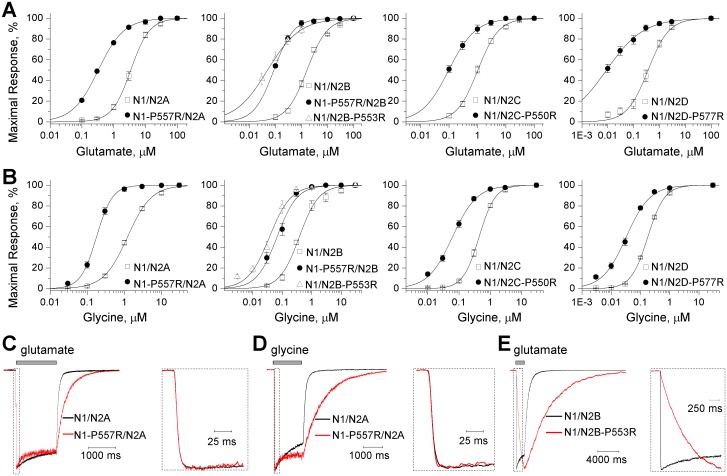
Conserved effects of the Pro552Arg mutation across GluN2 subunits.A,B, Composite concentration-response curves of glutamate in the presence of 100 μM glycine (A) and glycine in the presence of 100 μM glutamate (B) for human GluN1-P557R/GluN2A, GluN1-P557R/GluN2B, GluN1/GluN2B-P553R, and rat GluN1/GluN2C-P550R, and GluN1/GluN2D-P577R. The graph legends refer to GluN1 as N1 and GluN2 as N2. Fitted EC50 values are summarized in Tables 3 and 5. C,D, human GluN1-P557R/GluN2A significantly prolongs deactivation time course after removal of glutamate (C) or removal of glycine (D) on transfected HEK293 cells, but does not slow the rise time when the receptors were activated by the agonists. E, GluN1/GluN2B-P553R significantly slows rise time and prolongs deactivation time course. Fitted parameters describing the response time course are given in Table 6.